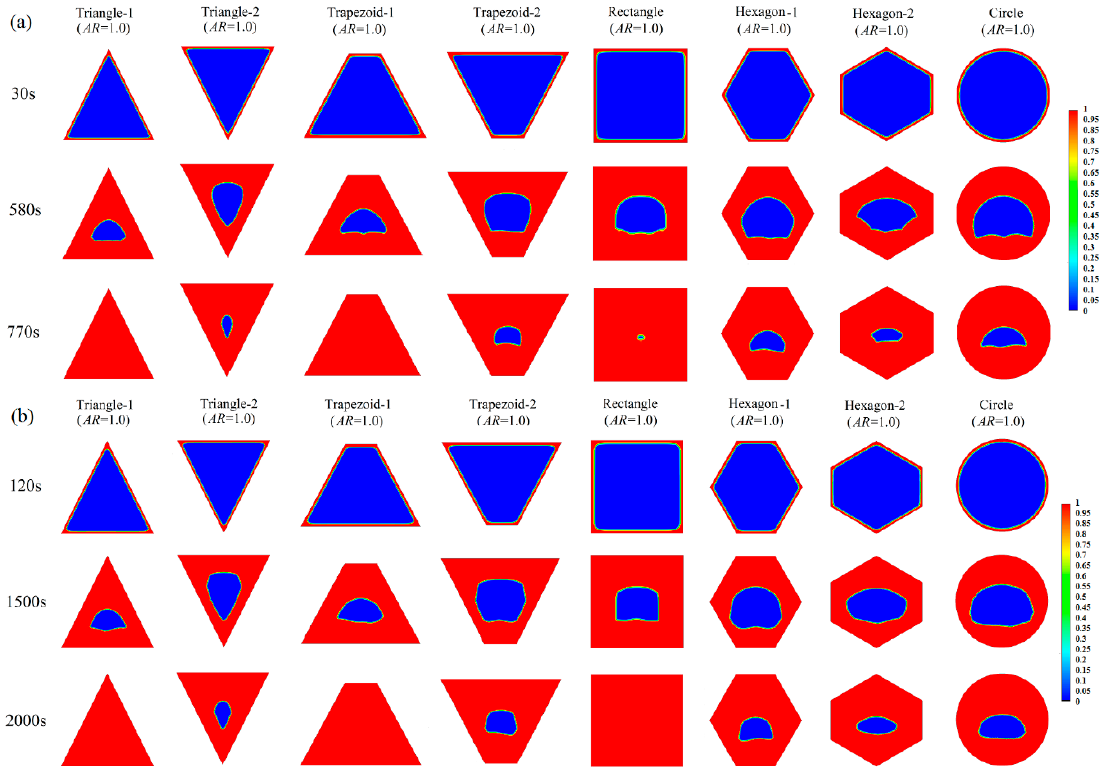
Figure A1. Liquid fraction contours at an initial, intermediate, and final melting time in triangular, trapezoidal, square, hexagonal, and circular cells ( AR = 1.0). ( a ) Ra = 4.83 × 10 6 ( A = 625 mm 2 ); ( b ) Ra = 3.87 × 10 7 ( A = 2500 mm 2 ).